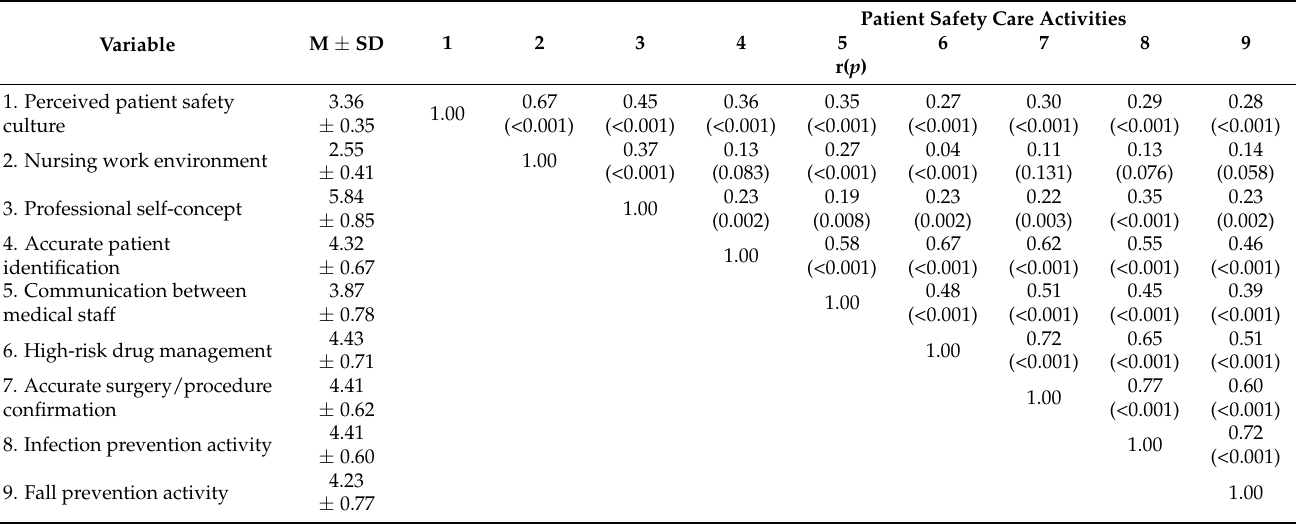
Table 2. Correlation between Perceived patient safety culture, Safety, Nursing Work Environment, Professional self-concept and Patient Safety Care Activities (N = 171).